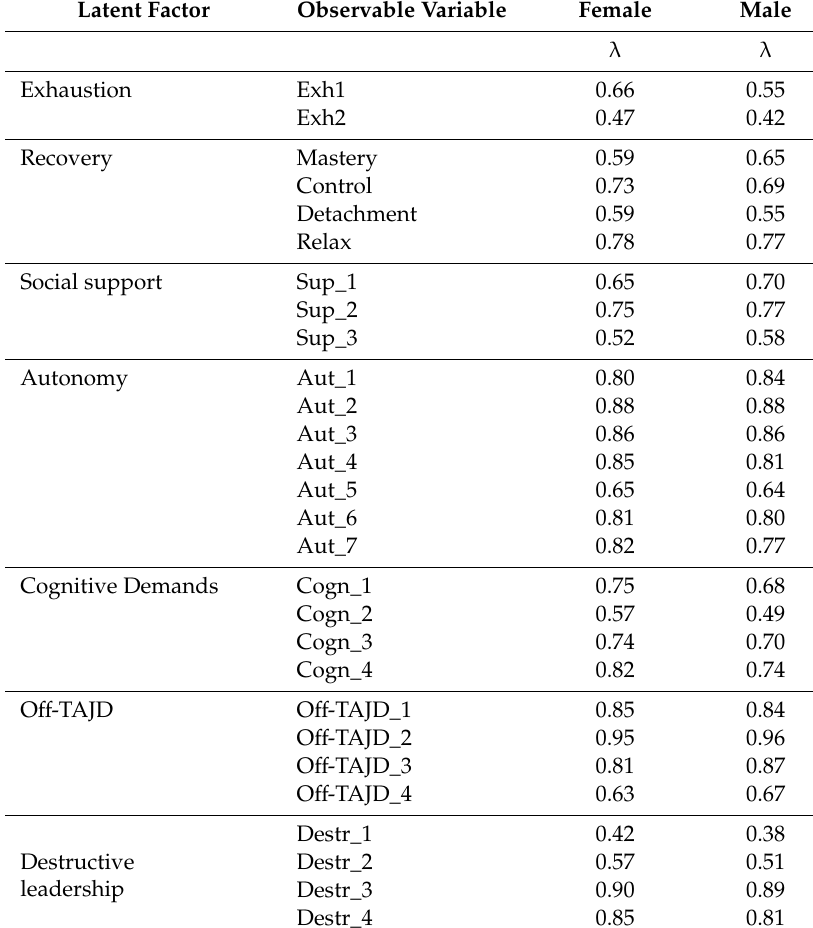
Table 2. Item loadings for all latent factors in the two samples (standardized values; p <